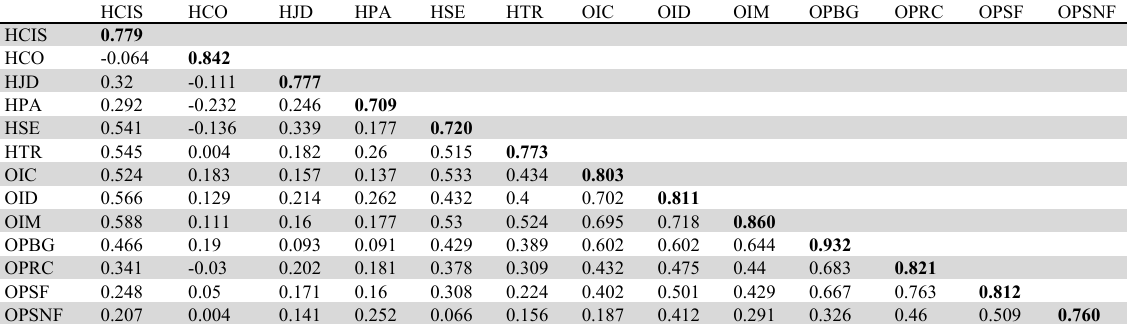
Fornell-Larcker Criterion for Discriminant